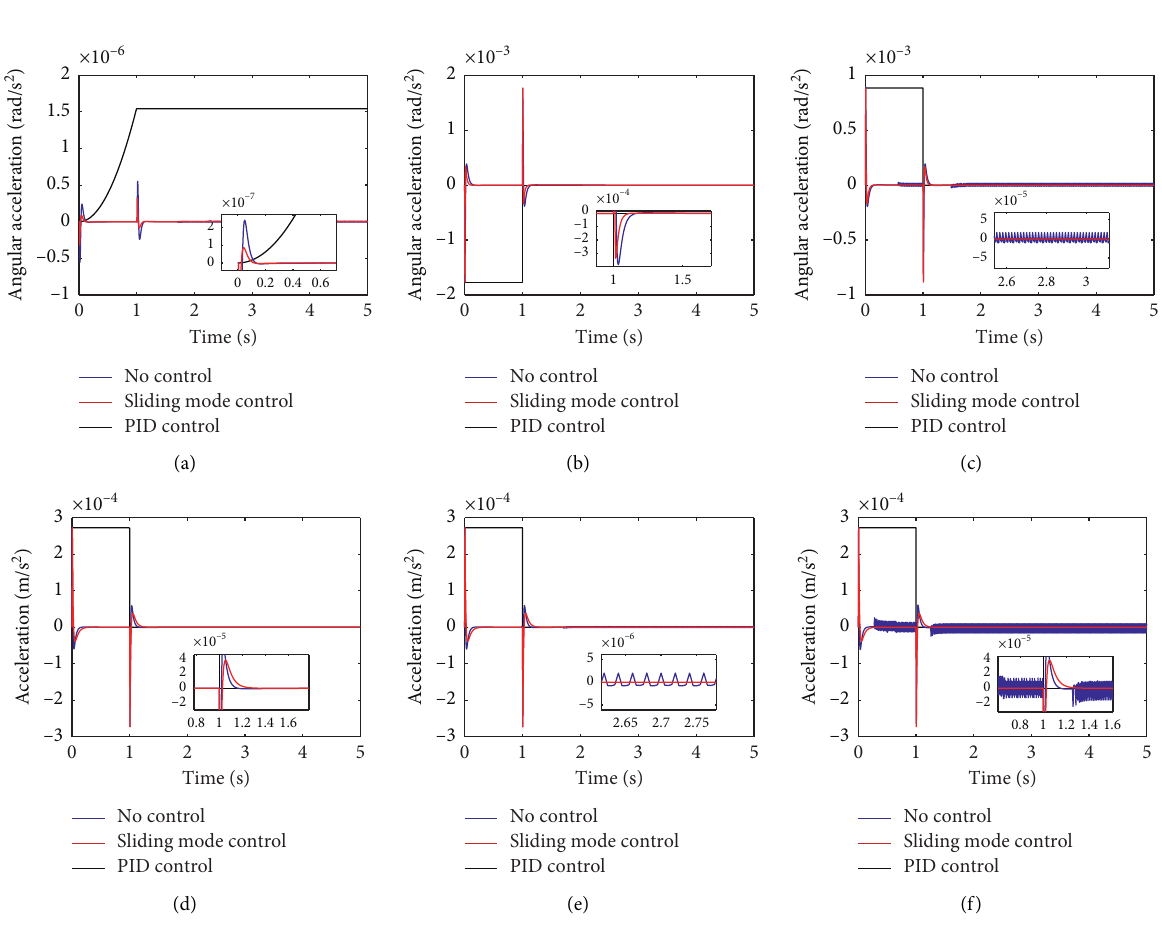
Figure 14: Floating platform acceleration and angular acceleration control: (a) € θ